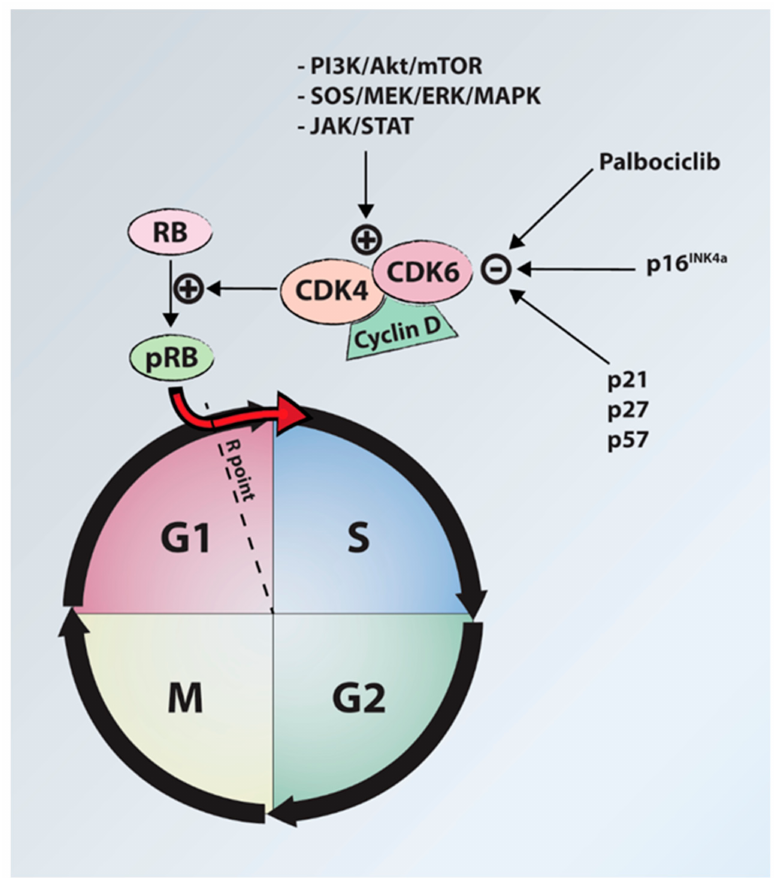
Figure 4. Diagram illustrating the role of cyclin D-dependent kinases (CDK4, CDK6) in progression from G1 phase to S phase. Palbociclib inhibits the action of CDK4/6, halting cell cycle progression. P16INK4a is often deficient in chordomas due to loss of the CDKN2A gene. RB, retinoblastoma protein; pRB, phosphorylated retinoblastoma protein; PI3K, phosphoinositide 3 kinases; Akt, ac- tive human serine/threonine protein kinase; mTOR, mammalian target of rapamycin; SOS, son of sevenless protein (guanine nucleotide exchange factor); MEK, mitogen activated protein kinase kinase; ERK/MAPK, extracellular signal-related kinases/mitogen activated protein kinases; JAK, janus kinase; STAT, signal transducer and activator of